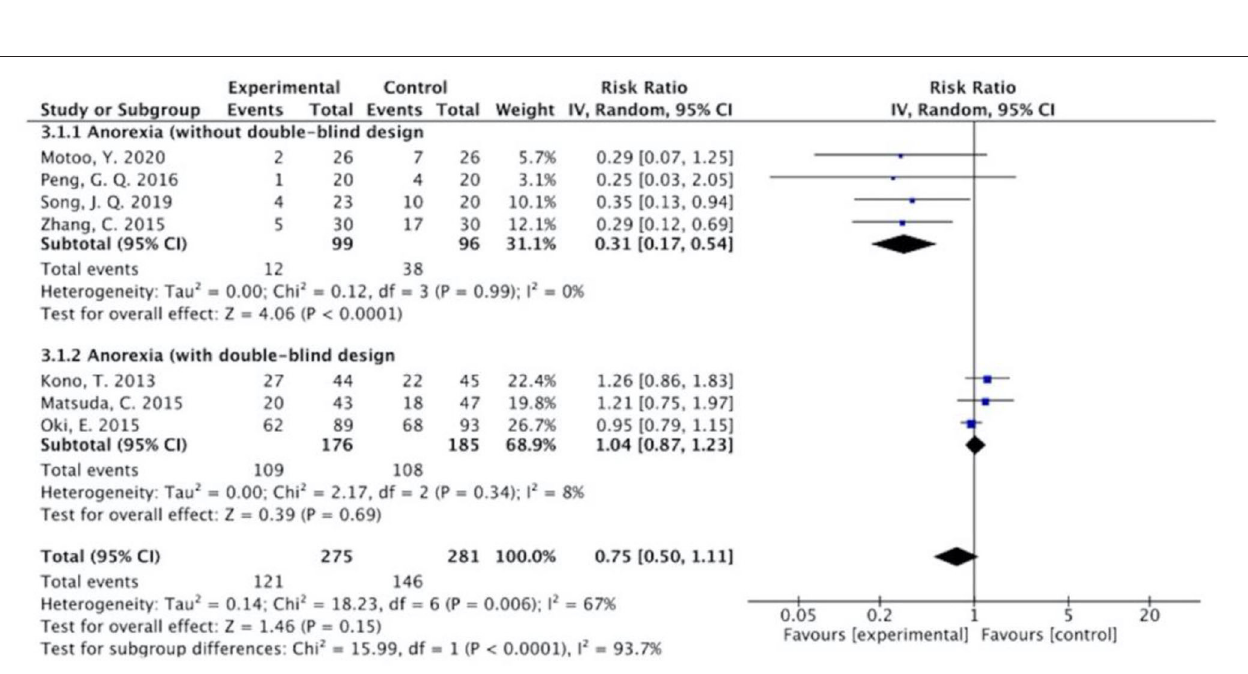
FIGURE 9 | Sub-analysis on the effect of herbal medicine in anorexia in chemotherapy-induced toxicity.